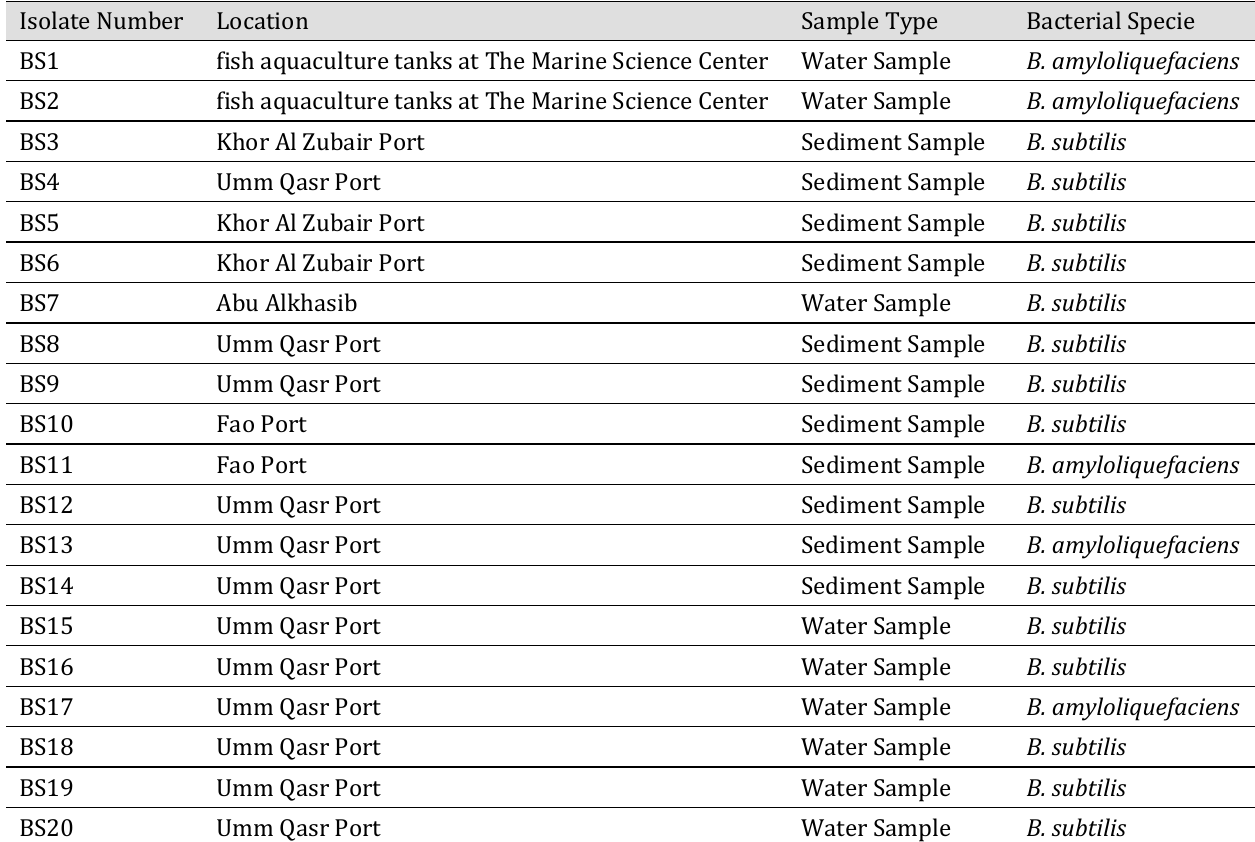
strains. Table 2. Sources of the Bacillus spp. Isolates used in the experiment.